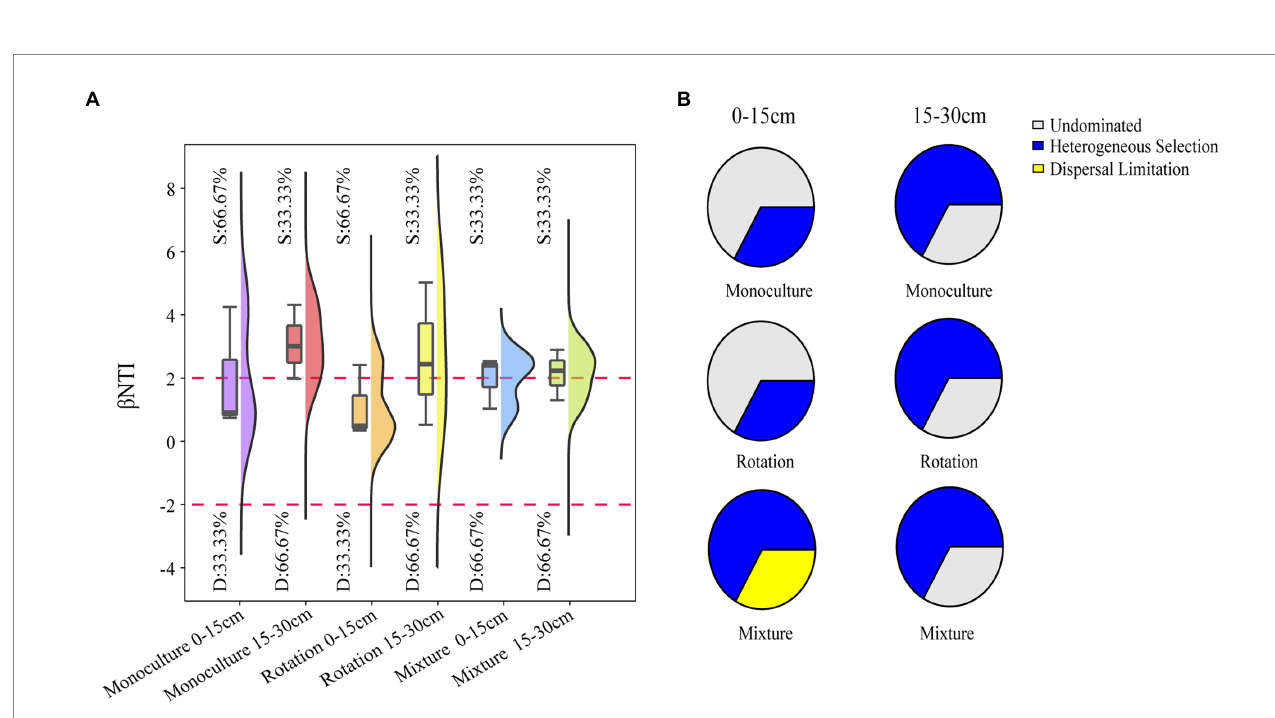
FIGURE 4 β NTI in different microhabitats across three cropping patterns at 0–15 cm and 15–30 cm soil depths (A) . Null model analysis of the community assembly ecological processes (B)